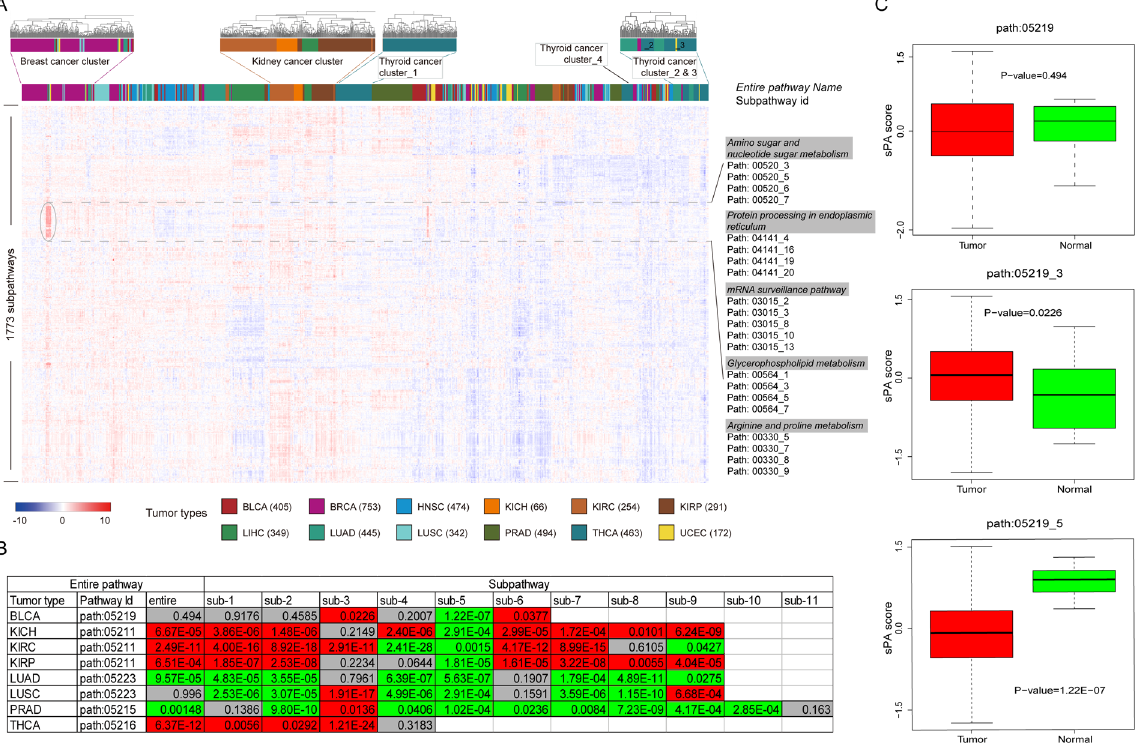
Figure 2. The analyses of subpathway activity scores. ( A ) The clustering results of subpathway profiles with 1,773 subpathways as rows and 4,508 samples as columns. Some sample clusters are shown as examples (above), and different colors correspond to each tumor type. ( B ) The performance of pathway or subpathway activities in distinguishing different conditions. The grey color designates nonsignificant results, The red color designates more activity in tumor samples, and the green color designates more activity in normal samples. ( C ) Path 05219 as an example (the first row in (B)